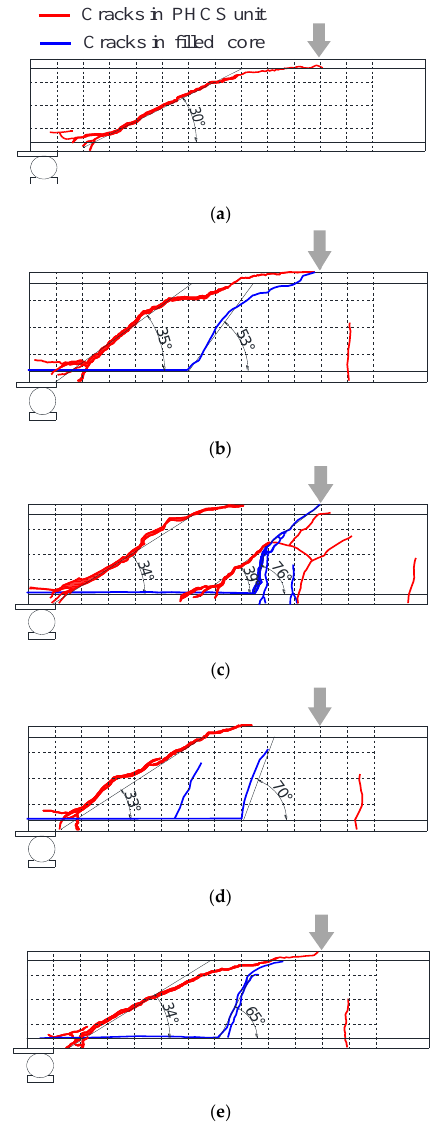
Figure 9. Di ff erence between crack patterns of the PHCS unit and filled core. ( a ) NR-0 / 4 specimen. (Inclined crack angle —30 ◦ ). ( b ) NR-2 / 4 specimen. (Inclined crack angle—PHCS unit: 35 ◦ , filled core: 53 ◦ ). ( c ) NR-4 / 4 specimen. (Inclined crack angle—PHCS unit: 34 ◦ , filled core: 76 ◦ ) ( d ) LR-2 / 4 specimen. (Inclined crack angle—PHCS unit: 33 ◦ , filled core: 70 ◦ ). ( e ) HR-2 / 4 specimen. (Inclined crack angle—PHCS unit: 34 ◦ , filled core: 65 ◦